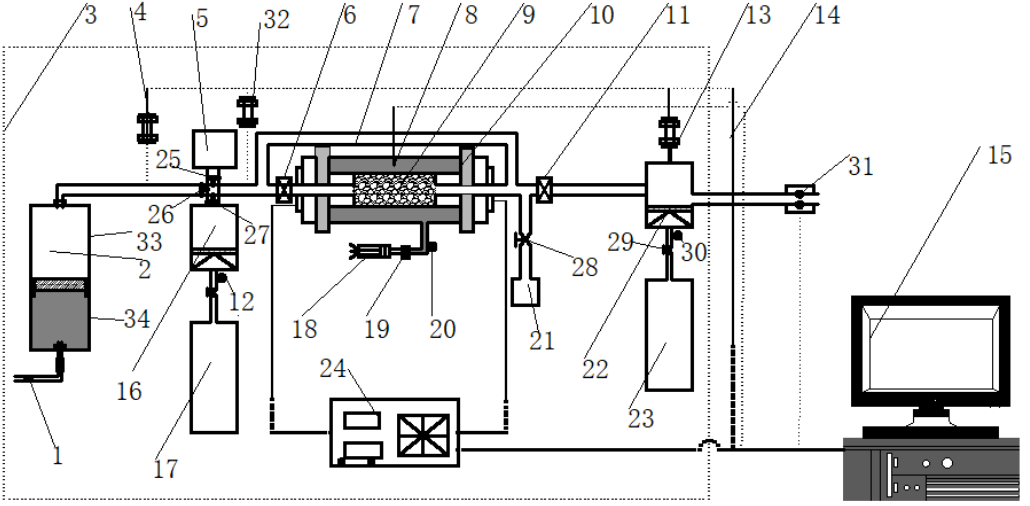
Figure 2. Schematic diagram of the experimental setup for simulating fracturing fluid imbibition and flowback in a shale. 1 — nitrogen cylinder; 2 — Fracturing fluid; 3 — constant temperature system; and flowback in a shale. 1—nitrogen cylinder; 2—Fracturing fluid; 3—constant temperature system; 4,13,32 — pressure Sensor; 5 — methane standard cylinder; 6,11,19,25,26,27,28,29 — valve; 7 — pipeline; 4,13,32—pressure Sensor; 5—methane standard cylinder; 6,11,19,25,26,27,28,29—valve; 7—pipeline; 8 — heating wire; 9 — tandem core samples; 10 — long core holder; 12,20,30 — pressure gaug; 14 — wire; 8—heating wire; 9—tandem core samples; 10—long core holder; 12,20,30—pressure gaug; 14—wire; 15 — computer; 16,22 — backpressure valve; 17,23 — backpressure air source; 18 — confining pressure 15—computer; 16,22—backpressure valve; 17,23—backpressure air source; 18—confining pump; 21 — vacuum pump; 24 — bridge meter; 31 — high precision gas flow meter; 33 — fracturing fluid sample cylinder; 34 — Nitrogen Standard Cylinder.